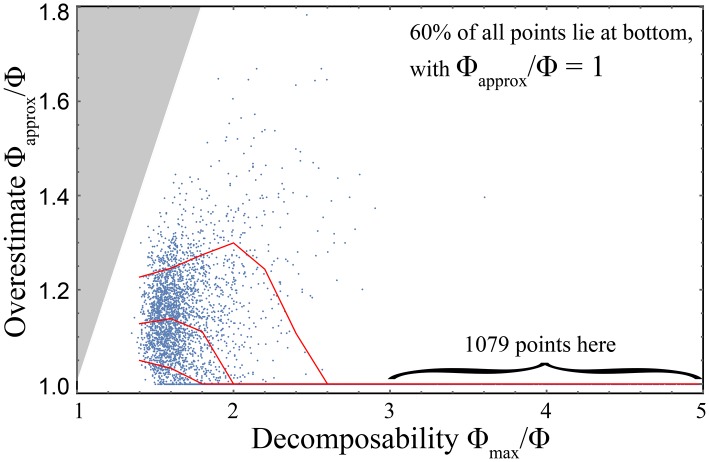
How well our fast Φ-approximation works for 7,000 simulations of the n = 16 ΦM-example described in the text.Whereas it is seen to be excellent at finding the best bipartition when not all are comparably good, (i.e., when Φmax/Φmin ≫ 1), the approximation is seen to overestimate Φ by up to 15% (the median) when there is no clear winner (left side). From top to bottom, the three curves show the 95th, 50th and 5th percentiles of the overestimation factor. The shaded region delimits the largest overestimation possible, when Φappox = Φmax.